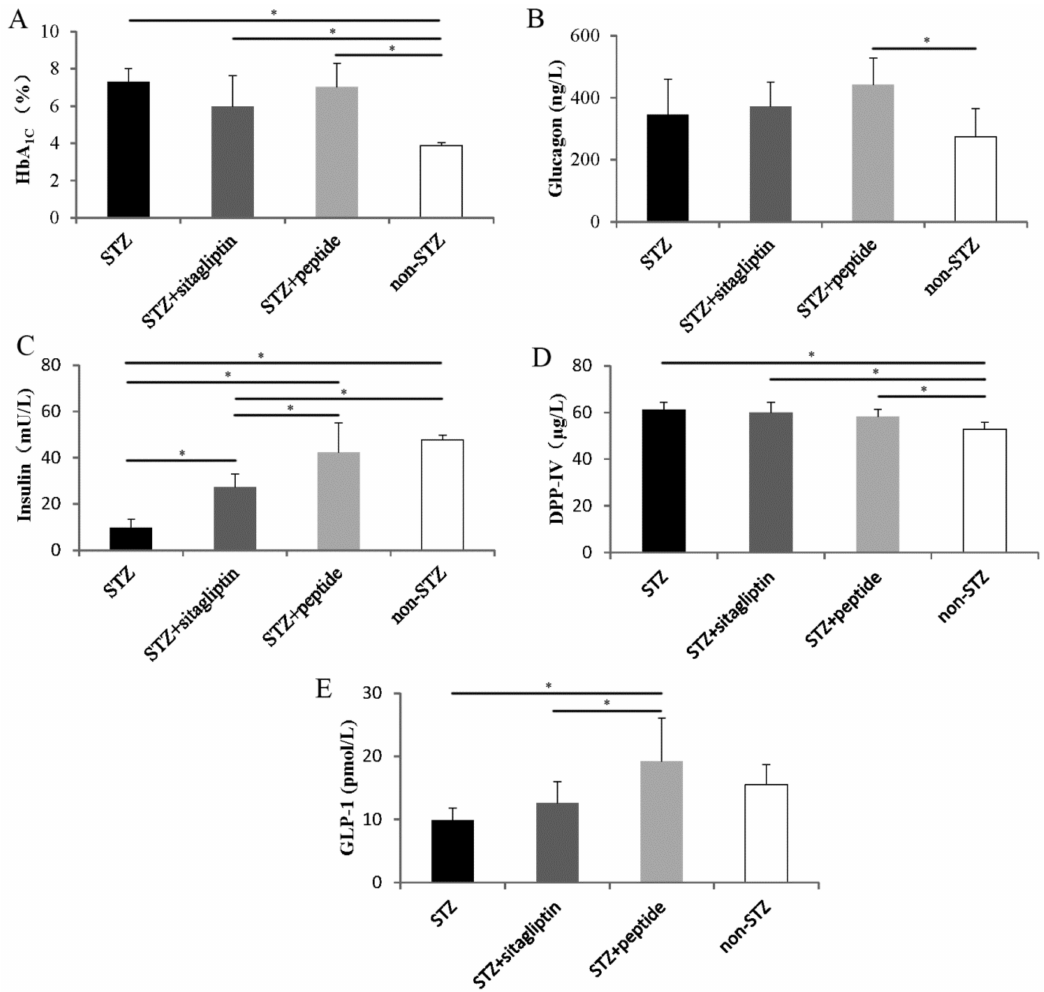
Figure 3. Effect of daily DPP-IV inhibitor administration on the ( A ) HbA1c levels, ( B ) plasma glucagon levels, ( C ) plasma insulin levels at day 57, ( D ) DPP-IV concentrations, and ( E ) glucagon-like peptide-1 (GLP-1) concentrations. The black columns represent the STZ control mice ( n = 9); the deep gray columns show STZ mice administrated with sitagliptin ( n = 6); the light gray columns represent STZ mice administrated with synthetic peptide II ( n = 7); and the white columns show the normal control ( n = 10). Data are presented as means ± SD. Statistical significance: * p <